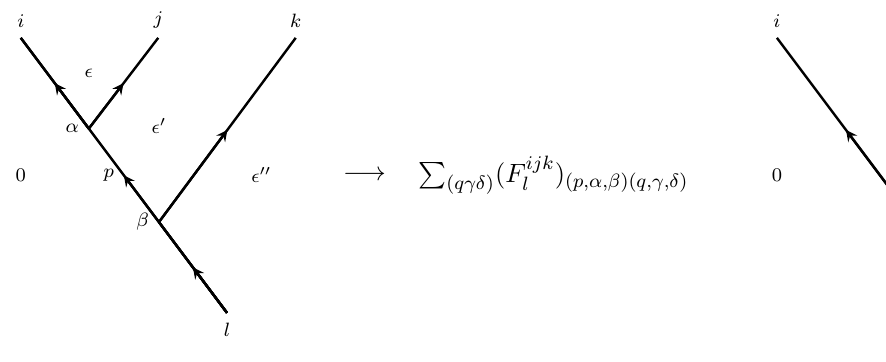
Figure 14 . De(cid:12)nition of F -symbols for ~ C